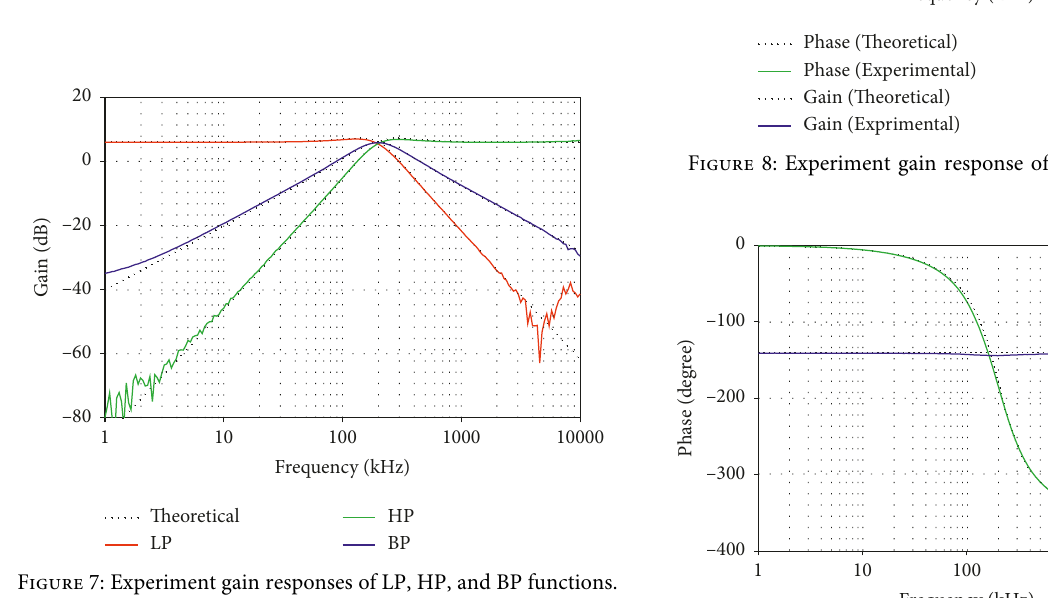
Figure 6: Experimental setup.